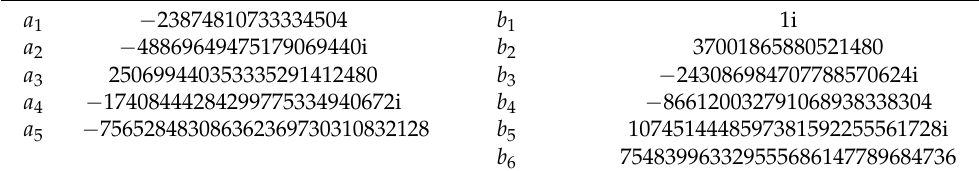
Table A1. Parameters for a forcing amplitude of 7.5%.